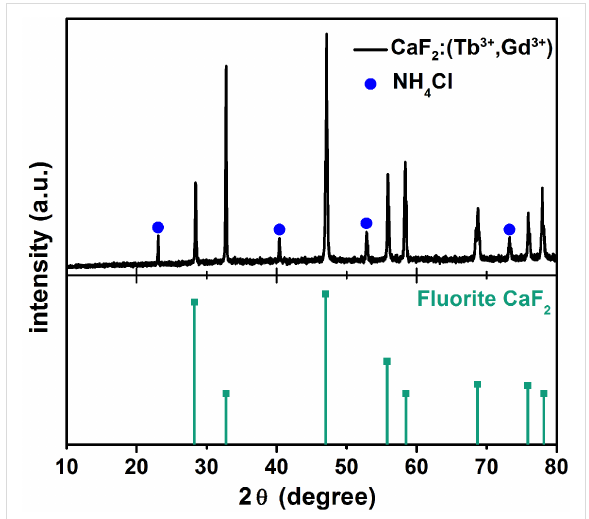
Figure 2: In the upper part, the XRD pattern of the CaF 2 :(Tb 3+ ,Gd 3+ ) NPs ( d = 5–10 nm, doping concentration of Tb 3+ and Gd 3+ : 1 mol %) is plotted. Below a reference spectrum from the database JCPDS (Joint Committee on Powder Diffraction Standards, Powder Diffraction File: 035-0816) is shown. The reflexes of both spectra appear at the same diffraction angles 2 θ , which indicates the crystalline structure (CaF 2 = fluorite) of the NPs. The blue points mark the peaks of NH 4 Cl.